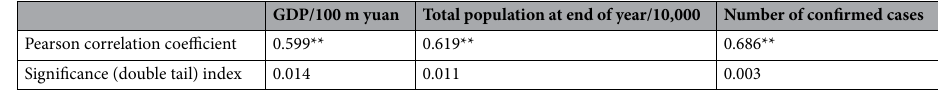
Table 4. Correlation index statistics of the number of destinations. ** P <